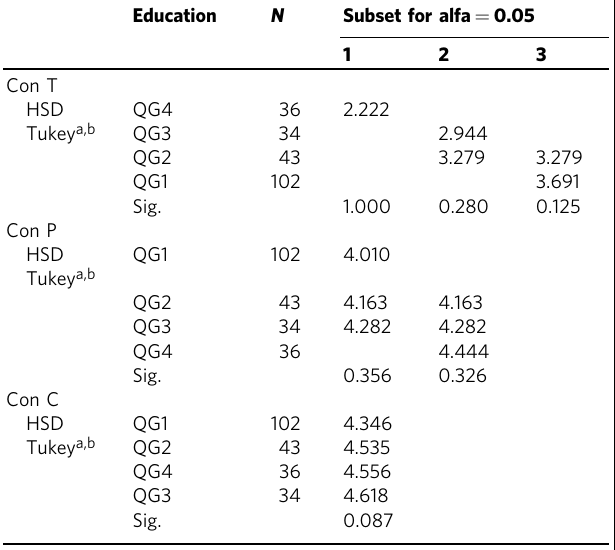
Table 9 Classi fi cation of groups according to the similarity of their averages regarding the “ content ”